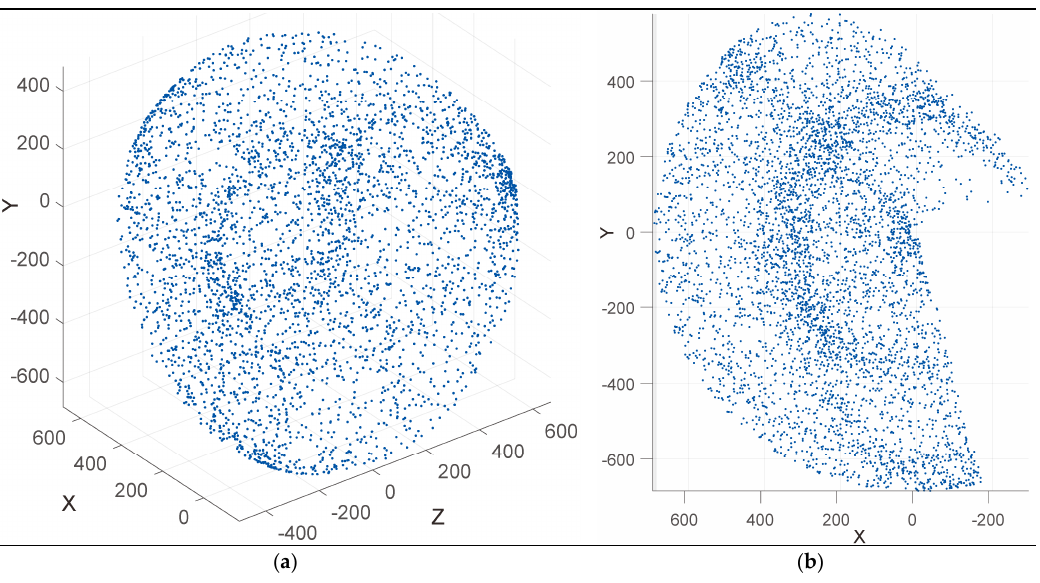
Figure 7. The workspace of the right arm of the 5-DOF upper-limb exoskeleton (mm): ( a ) Isometric view; and ( b ) right view.